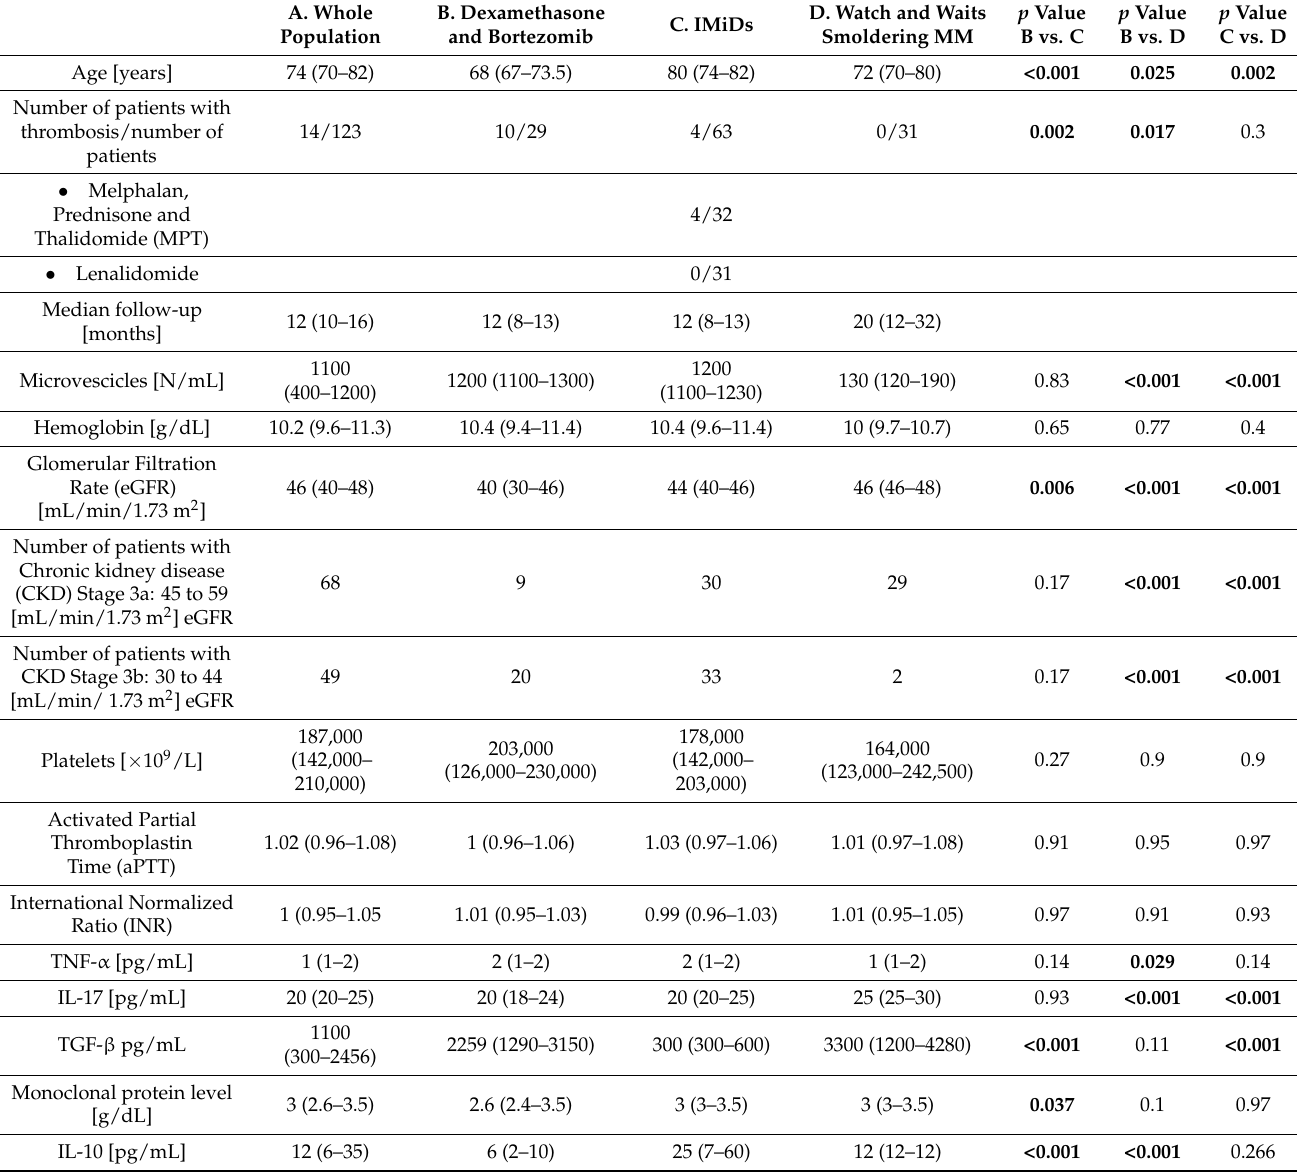
Table 1. Laboratory exams and inflammatory parameters in: A. whole cohort B. Dexamethasone and Bortezomib C. IMiDs D. Watch and Wait Smoldering MM. Data are reported as “median